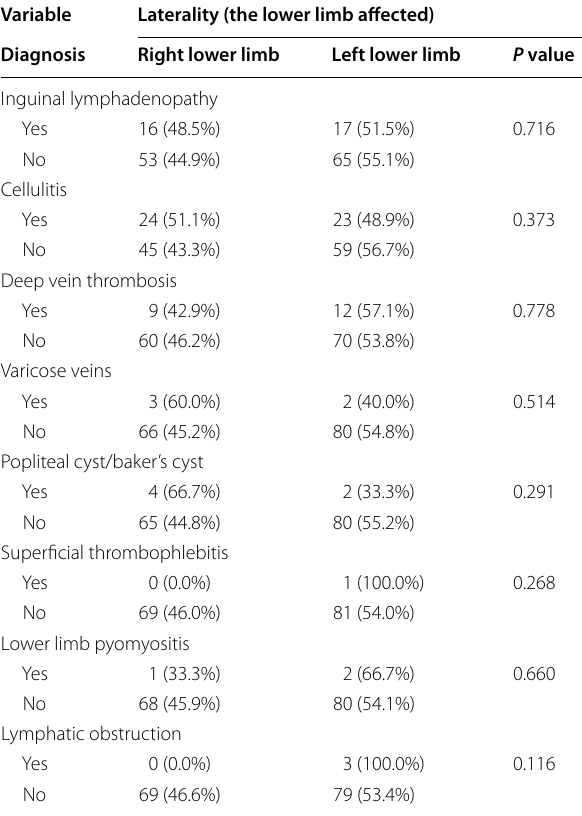
Table 7 Distribution showing the relationship between laterality and ultrasound